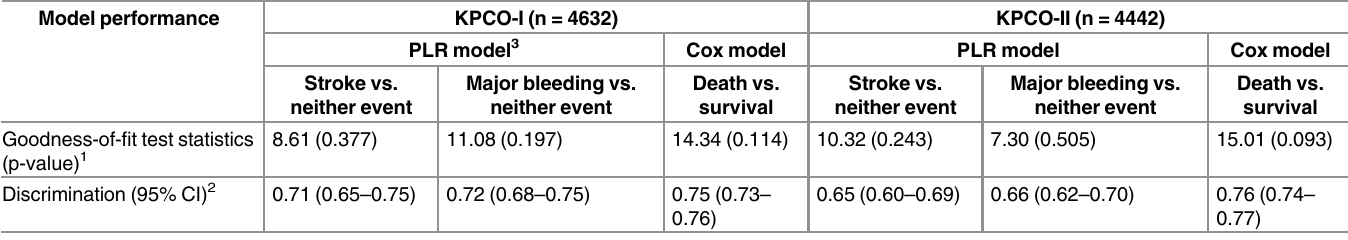
Table 7. Model performance of PLR model for stroke and major bleeding and Cox model for death in KPCO-I and KPCO-II cohorts. Model